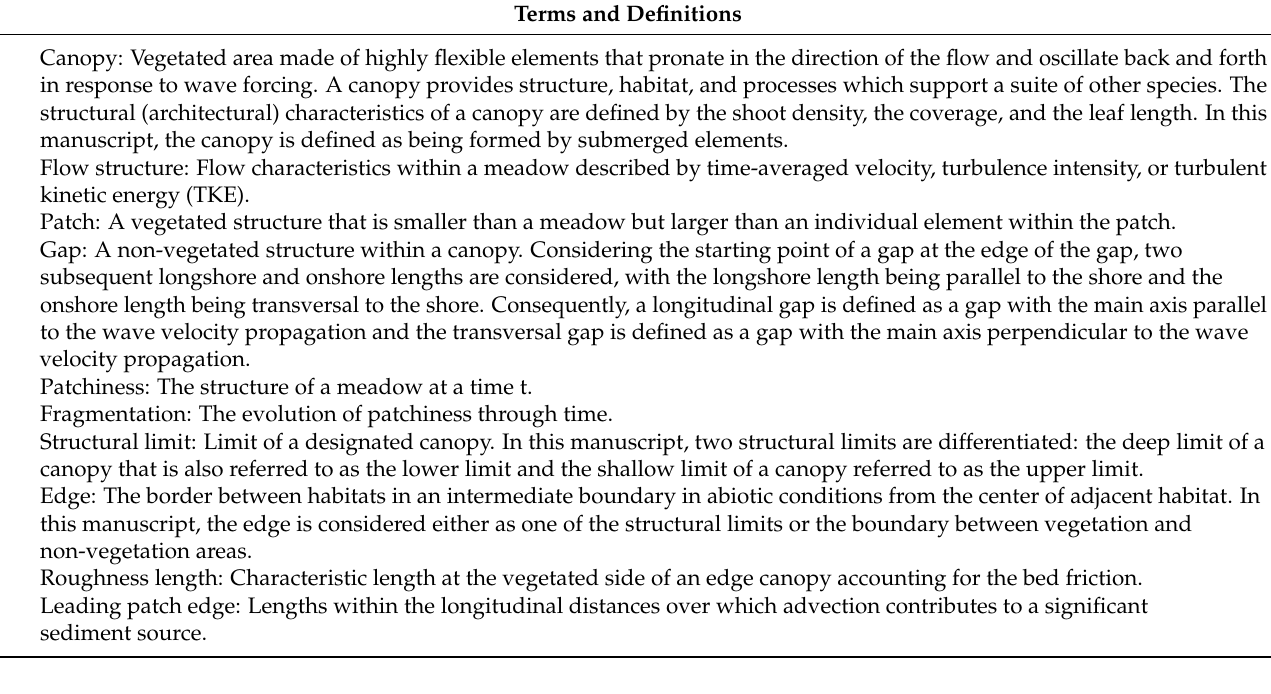
Table 1. List of terms described in the manuscript and corresponding